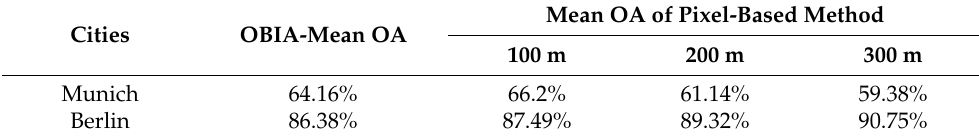
Table 3. OA results of two German cities.